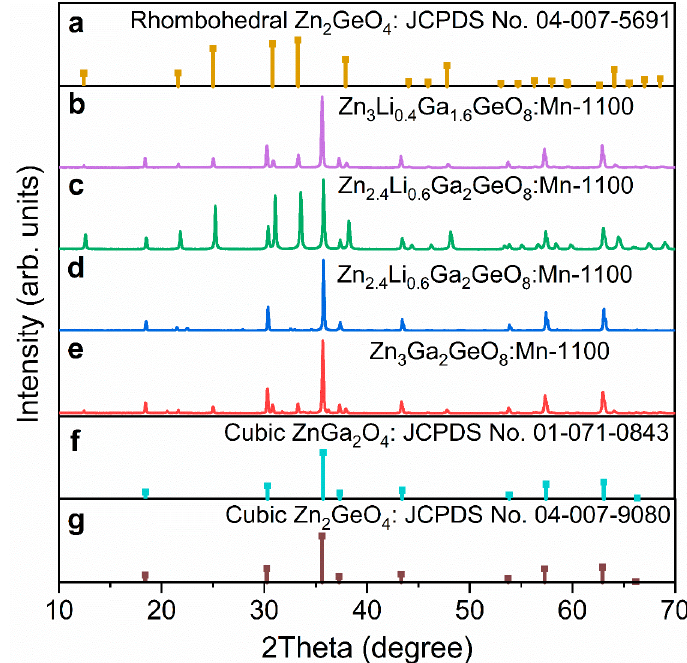
Figure 1. XRD patterns of Zn 3 Li 0.4 Ga 1.6 GeO 8 :Mn, Zn 2.4 Li 0.6 Ga 2 GeO 8 :Mn and Zn 3 Ga 2 GeO 8 :Mn phos-